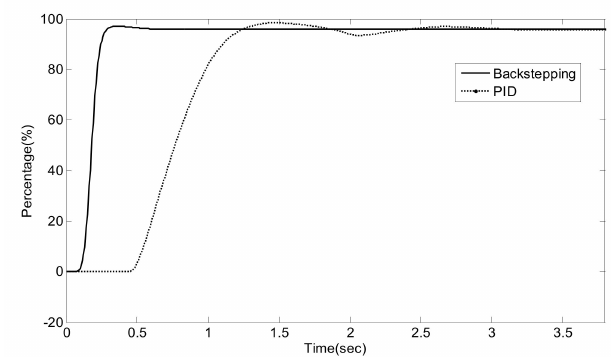
Figure 19. NO / NO 2 = 1 / 1, NOx conversion e ffi ciency.